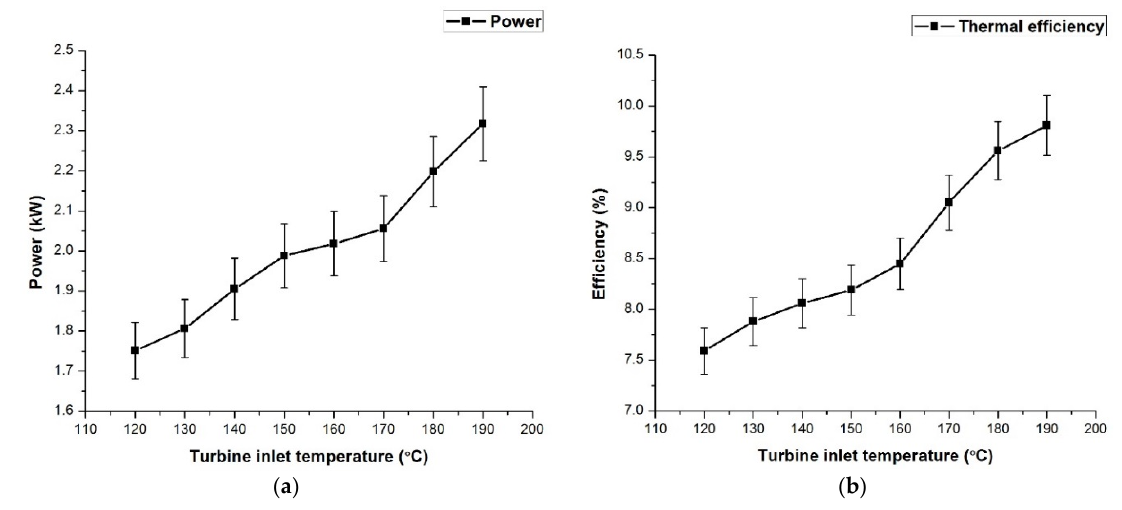
Figure 11. Variation of power produced ( a ) and thermal efficiency ( b ) with turbine inlet temperature.